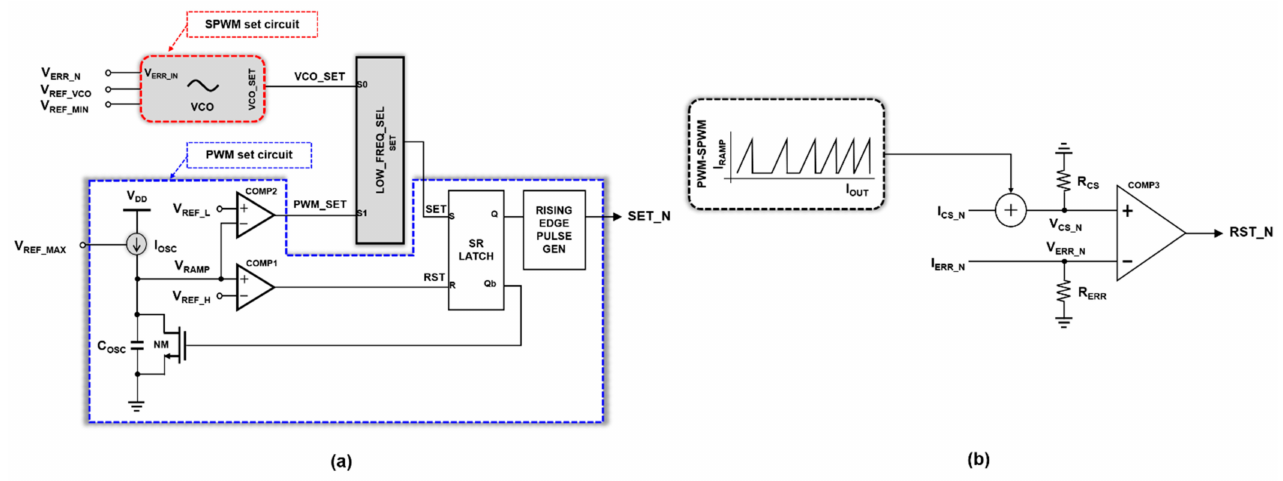
Figure 8. PWM–SPWM controller circuit: ( a ) SET_N generation circuit; ( b ) RST_N generation